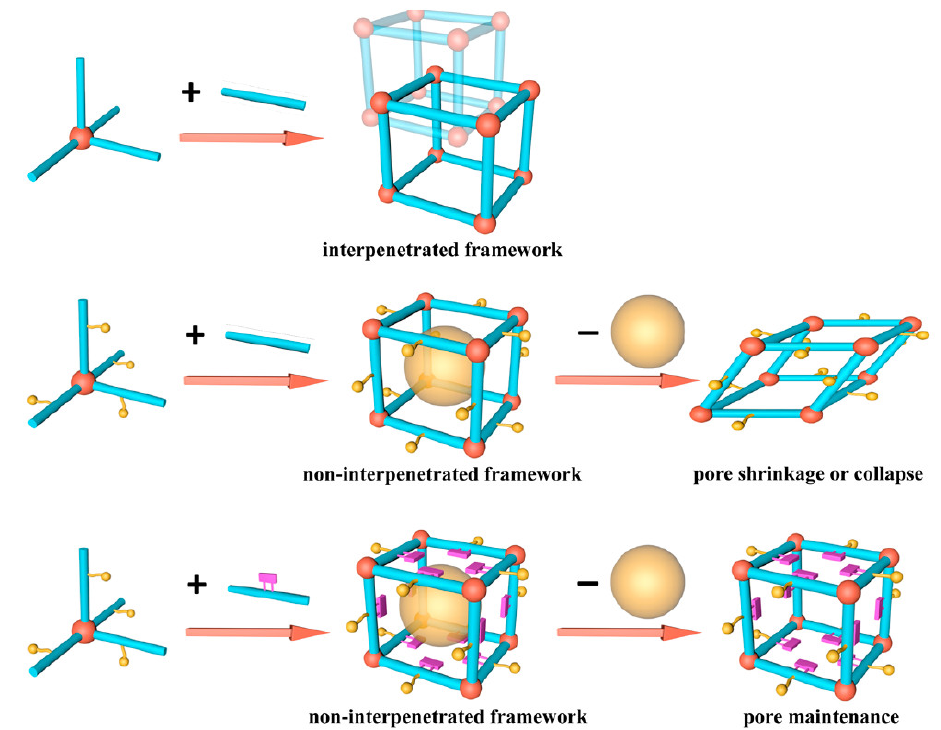
Figure 4. Different possibilities to create 3D COFs by steric hindrance method. Reprinted (adapted) with permission from [37]. Copyright 2020 American Chemical Society.